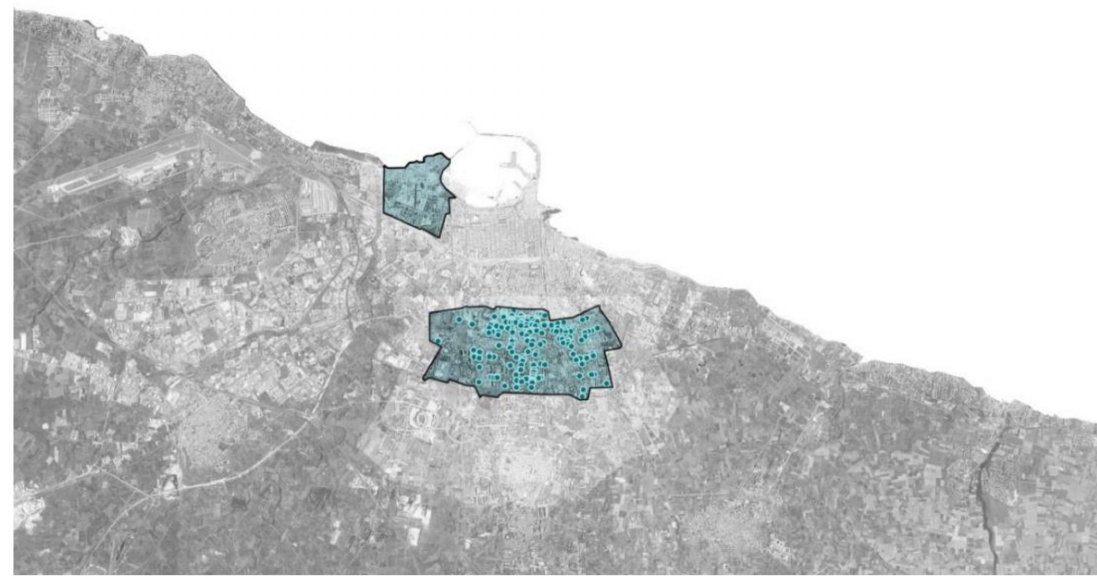
Figure 2. Localization of the study sample properties in the OMI semi-central area of the city of